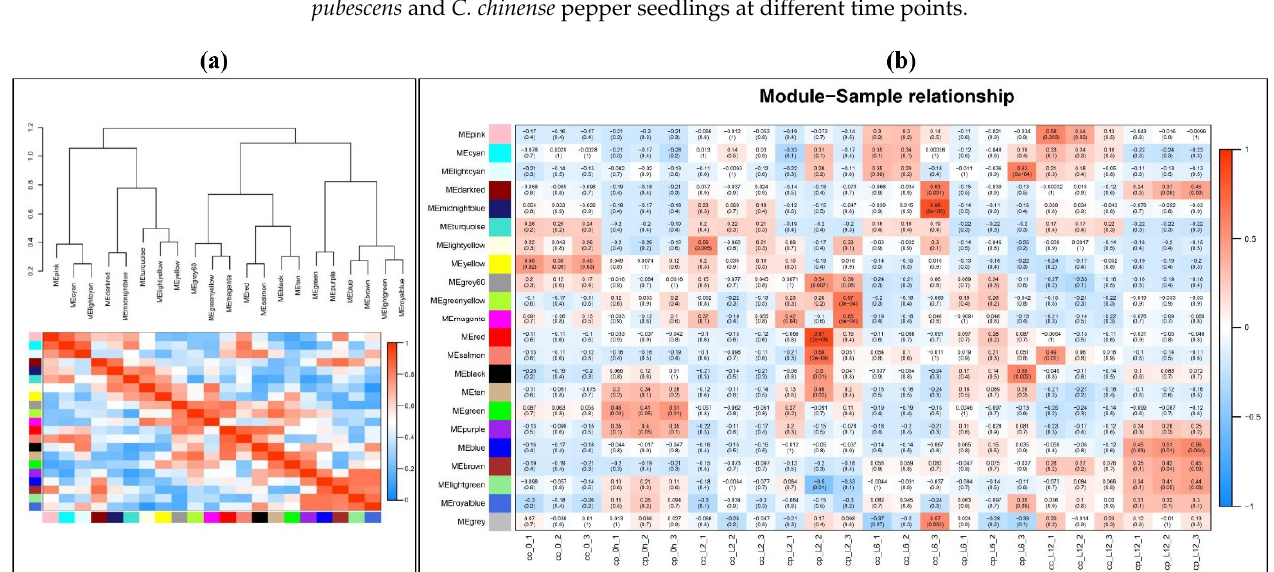
Figure 3. WGCN analysis of cold-tolerant and cold-sensitive samples under different time durations of cold stress. ( a ) Genes were assigned to one of the 22 modules. The sequence diagram is shown at the top of the image. The bottom of the figure shows the different color gene modules and the number of bases they contain. ( b ) Correlation analysis between module and sample. The number on each cell is the correlation coefficient between each module gene and sample, and the number below is the corresponding p-value. Among these modules, the blue module is the most relevant to cold resistance.